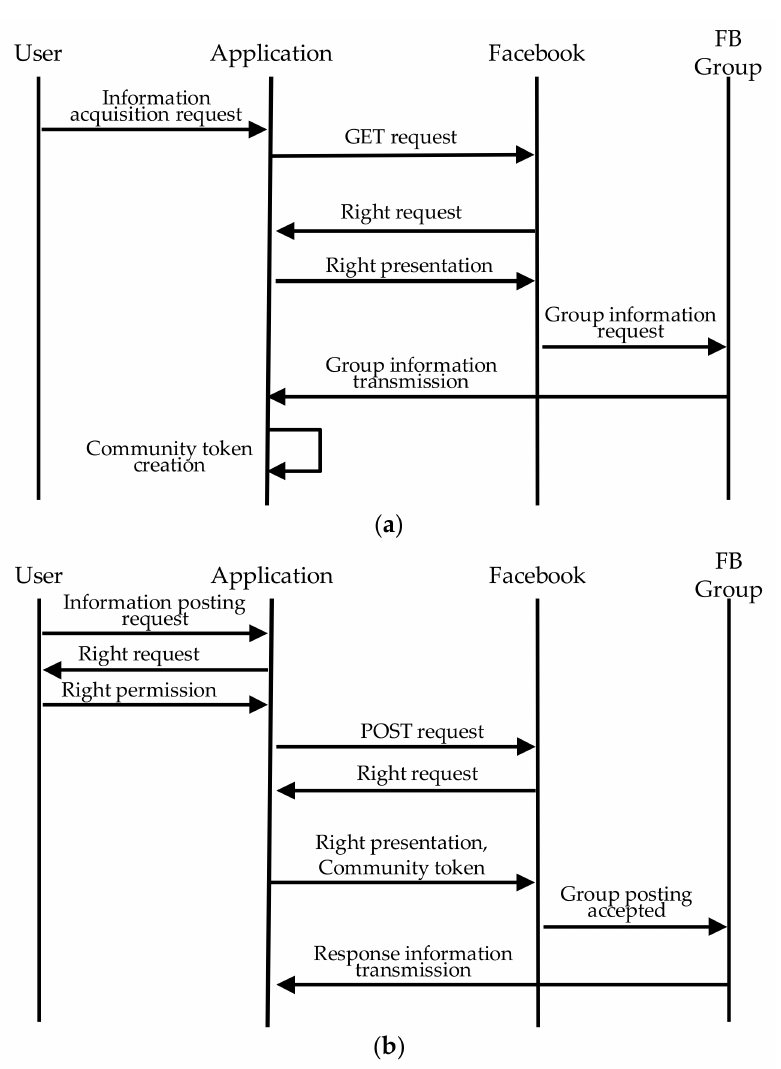
Figure 3. Sequences for group information acquisition and community token sharing. ( a ) Group information acquisition; ( b ) Community token